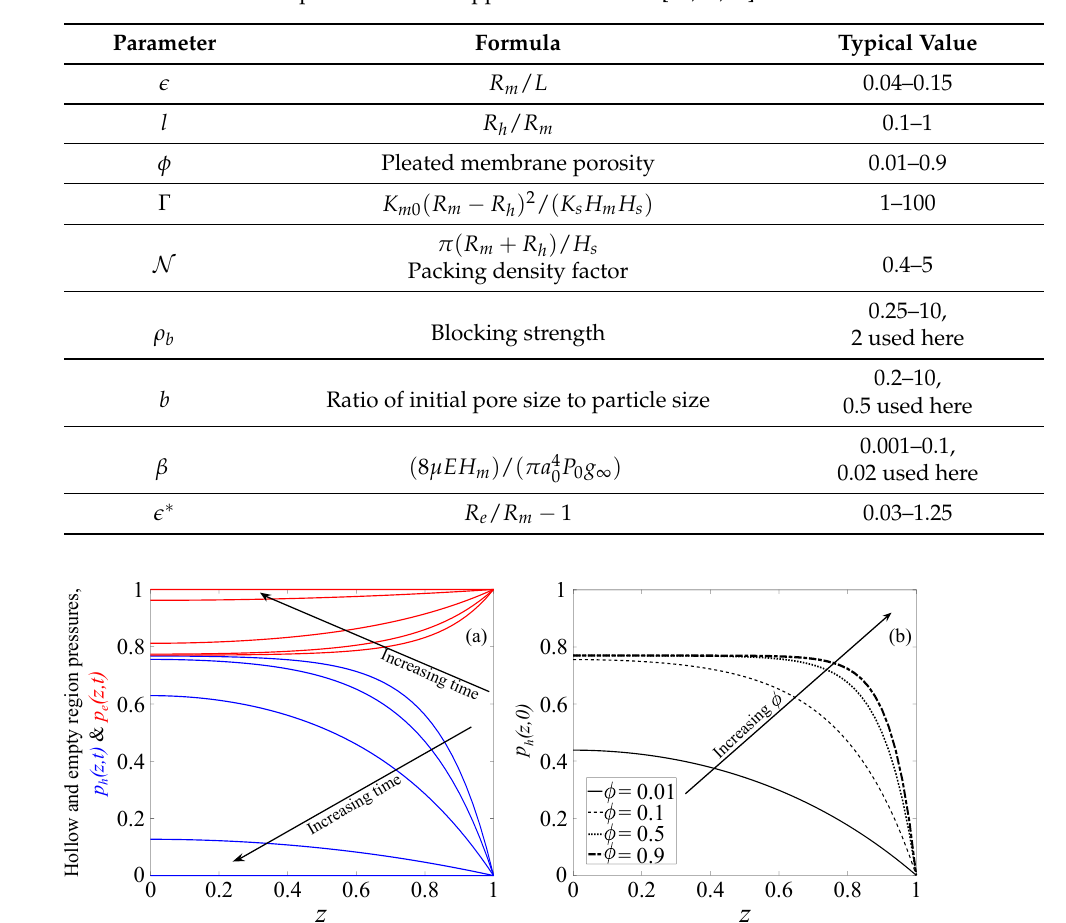
Figure 2. ( a ) Pressure in the hollow region p h ( z , t ) (blue) and empty area p e ( z , t ) (red), for φ = 0.5 at several different times t = 0, 0.2 t f , 0.4 t f , 0.6 t f , 0.8 t f , and t f (the final filtration time) with the membrane porosity φ = 0.5. ( b ) The initial pressure in the hollow region p h ( z ,0 ) for several different values of local porosity, φ . In both figures, we use the parameters l = 0.5, Γ = 10, N = 1, β = 0.02, ρ b = 2, b = 0.5, and (cid:101) ∗ =